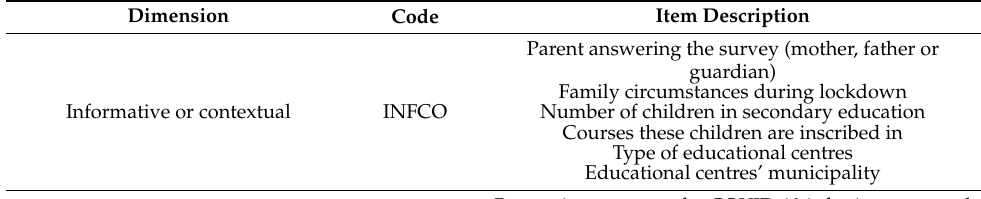
Table 1. System of dimensions, codes, and item